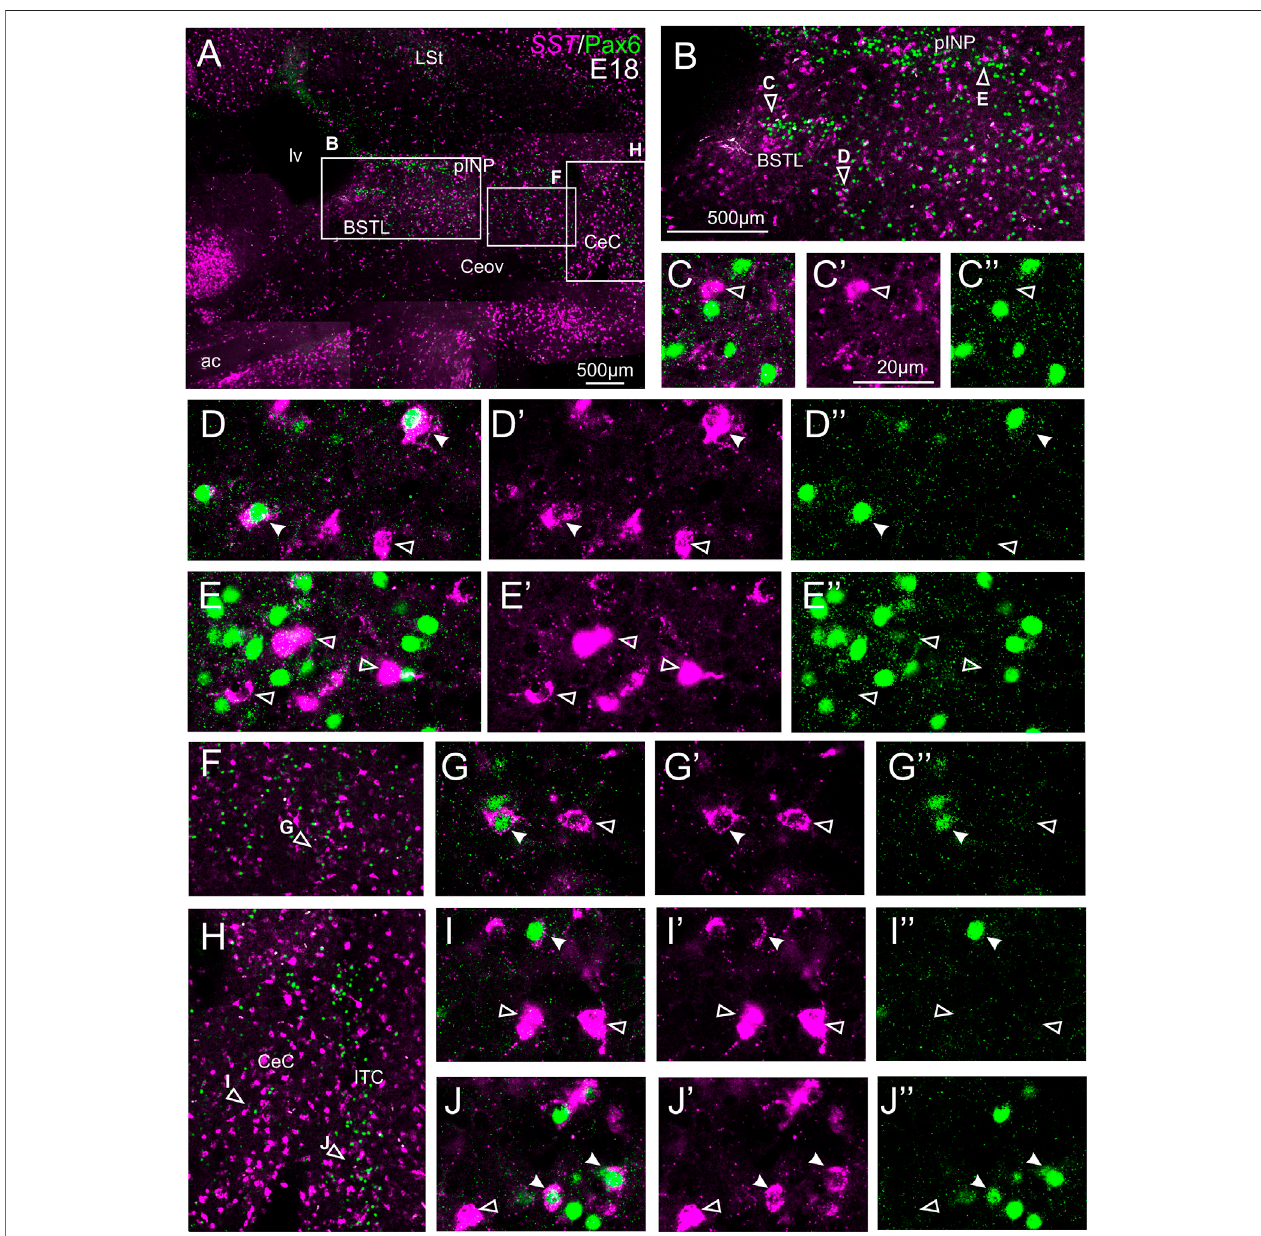
FIGURE7 | Double fl uorescence labeling of somatostatin ( SST ) and Pax6 in the chicken centralextended amygdala at E18. (A) General view (×10 objective) of the subpallium in a frontal section at the level of the anterior commissure, processed for indirect fl uorescent in situ hybridization for SST (magenta) and immuno fl uorescence for Pax6 (green). (B , F,H) show ampli fi cations of the squared areas in (A) , at the level of the BSTL and medial pINP (B) , Pov (F) , and CeC and ITC (H) . Details (×40 objective, only one single z level of the confocal stack) of the areas pointed with arrowheads in (B,F,H) are shown in (C – C 99 ) (for medial BSTL), (D – D 99 ) (for lateral BSTL), (E – E 99 ) (for medial pINP), (G – G 99 ) (for Pov), (I – I 99 ) (for CeC) and (J – J 99 ) (for ITC) (merged plus separate magentaand green channels areshown). In these details, cells coexpressing SST and Pax6 are pointed with a fi lled arrowhead, and cells single labeled for SST are pointed with an empty arrowhead (only a few examples